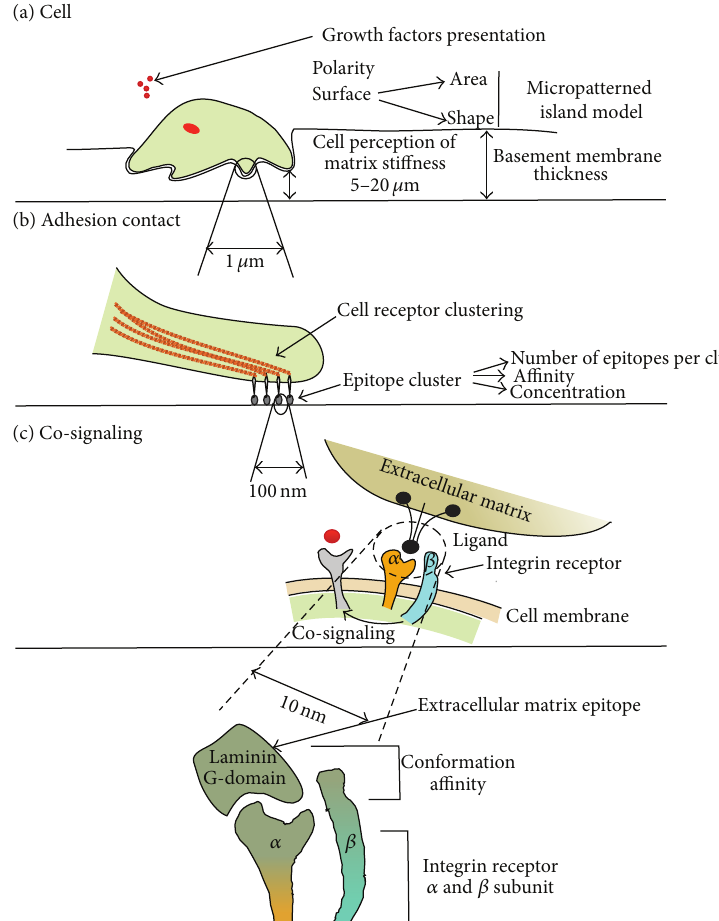
Figure2: Interactionsofthecellstructureswithadhesivematrixepitopes:fromcell-sizescaletonanoscale .(a)Certaineventsofmatrixperception by the cell occur on scale comparable with size of the cell. Cells distinguish between 2D and 3D presentations of the epitopes. In case when 3D matrix is presented only from the basal side of the cell, thickness of the matrix layer can be critical for cell perception of the matrix. Cell perceptionoftheunderlyingmatrixthicknessrangesapproximatelyfrom5to20micrometers,whichiscomparablewithaveragecelldiameter. In cases when matrix defines the geometrical properties of cell adhesion surface, such as in case of adhesion islands model, adhesion area and shape can be influential factors for stem cell behavioral choices. (b) Cell propagates and spreads on the matrix due to spreading of filopodia, which form stable adhesion contacts with the matrix. In order to achieve stability of such adhesion contact, it takes not a single epitope but cluster of epitopes which, in turn, enable clustering of cell receptors and signaling to the cell. The following parameters of epitope clusters may be important to influence cell behavioral choices: number of epitopes per cluster, space between clusters, and so forth. Topography on micro- and nanoscale can also be influential on cell behavior. (c) Such events like co-signaling (synergy between the different cell receptors, i.e., receptor for matrix epitopes and receptor for growth factors) occur on even smaller scale. Importantly, the natural matrix adhesion molecules areverylargeones(molecularweightupto1millionDaltons,lengthupto300nanometers),comparedtotypicaladhesionpeptides(composed of several amino acids, with molecular weight below 1 thousand Daltons). Apparently, one has to consider geometry of functional clusters of receptors and matrix molecules on molecular level. (d) Affinity and specificity of matrix adhesion epitopes interactions with cell receptors occur on even smaller